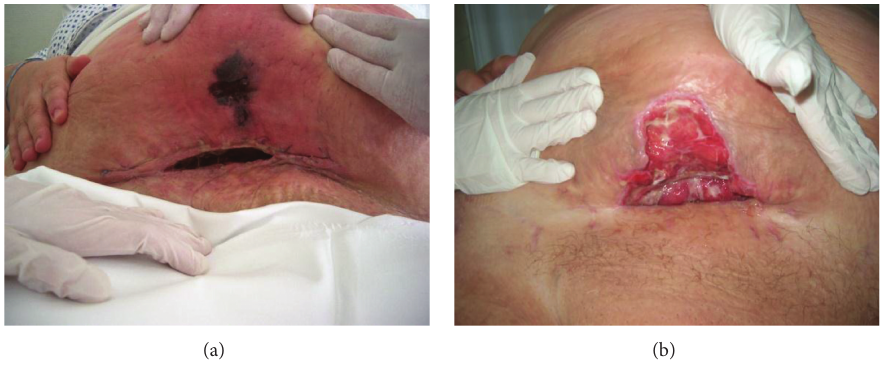
Figure 2: Wound healing on days 10 and 21 after